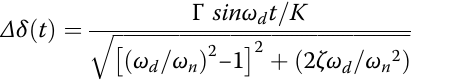
with amplitude Γ and angular frequency ω d . ω n ffiffiffiffiffiffiffiffiffiffiffiffi p ¼ K = T refers to the generator natural frequency, K J is the synchronous torque coefficient of the generator, and T J is the inertia constant of the generator. ζ ¼ D = 2 p ffiffiffiffiffiffiffiffiffiffi T ω ¼ D = 2 KT is the damping coefficient and D is J n J the generator damping.